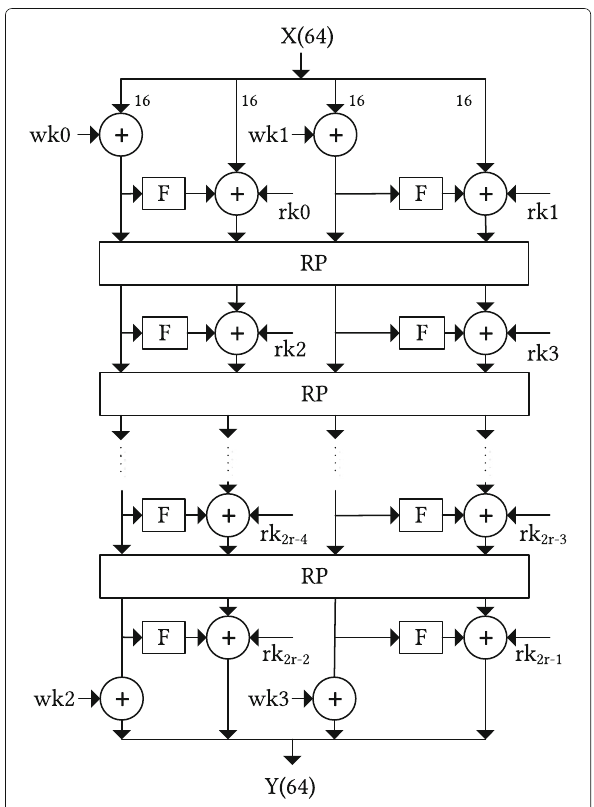
Fig. 7 The encryption process of Piccolo